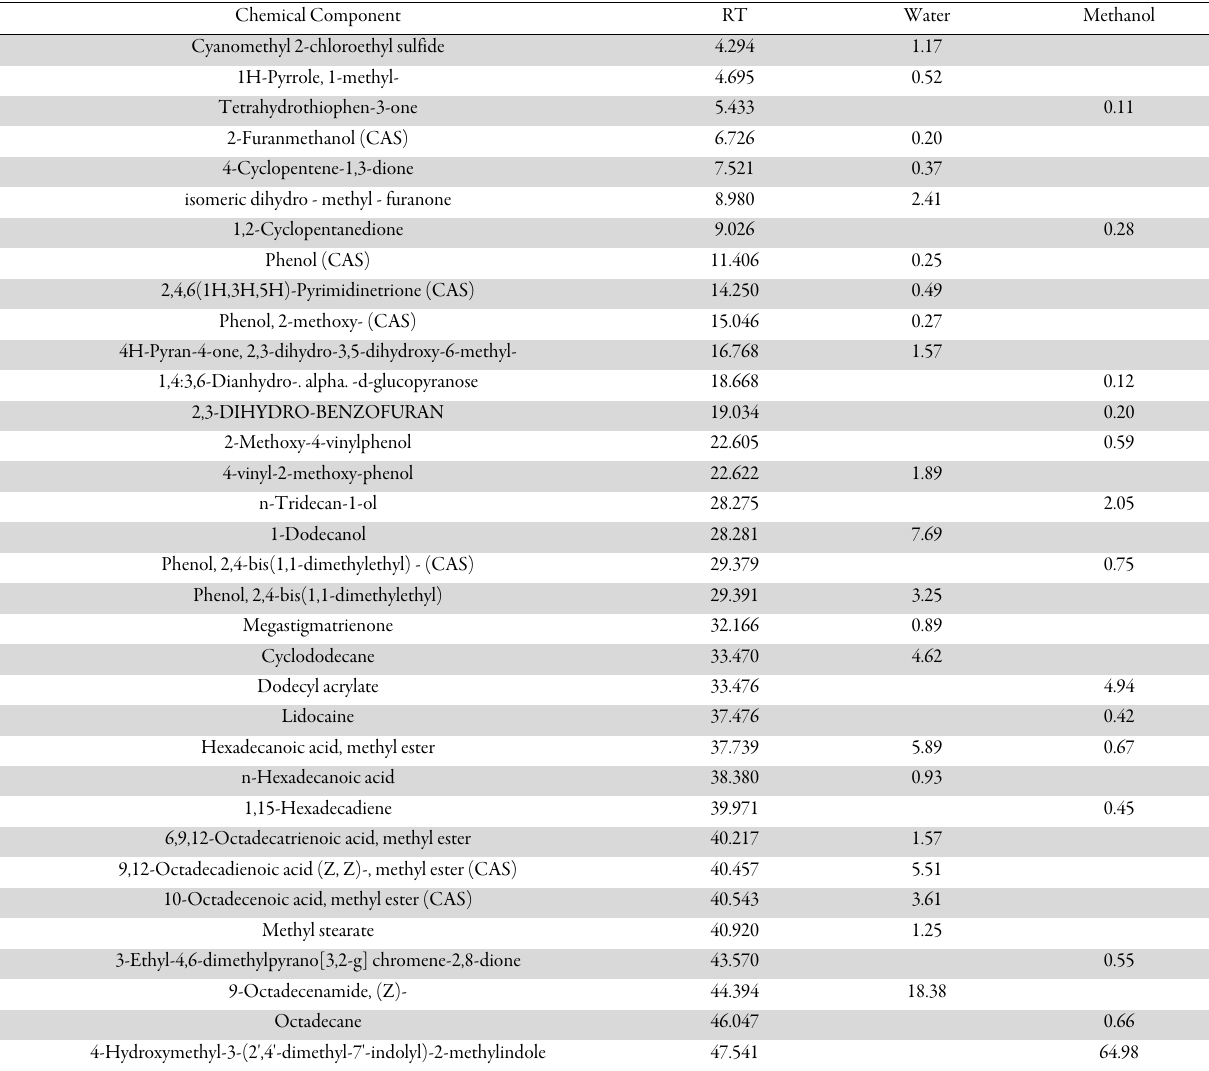
Table 1. Chemical composition of water and methanol extracts of S. libanotica